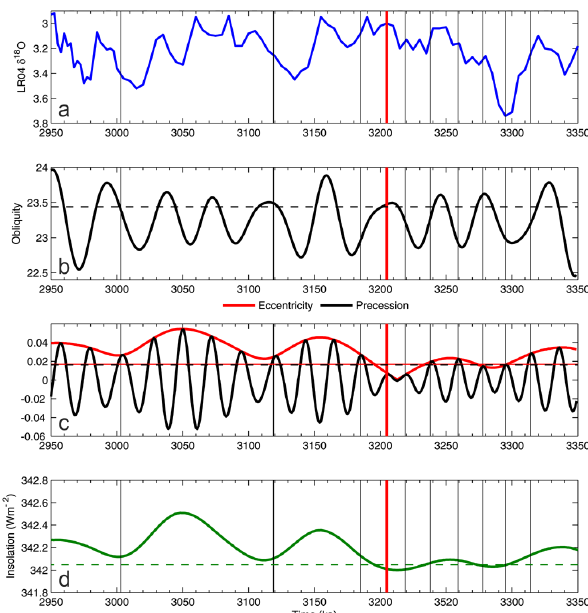
Fig. 7. Orbital variations between 2.950 and 3.350Ma. (a) the Lisiecki and Raymo (2005) benthic oxygen isotope stack. (b) obliq- uity, with dashed horizontal showing the present-day value, (c) pre- cession and eccentricity, with horizontal dashed black and solid red lines showing present-day values for eccentricity and precession, as derived from the astronomical solution of Laskar et al. (2004; La04). (d) the variation in global mean TOA insolation according to La04, with the dashed horizontal green line denoting the modern value of global mean insolation. The vertical black solid lines and the solid red line through each panel represent the best-fit solutions to the modern orbits as well as the selected initial time slice for in- vestigation discussed in Sect. 6.2 (figure modified from Haywood et al.,